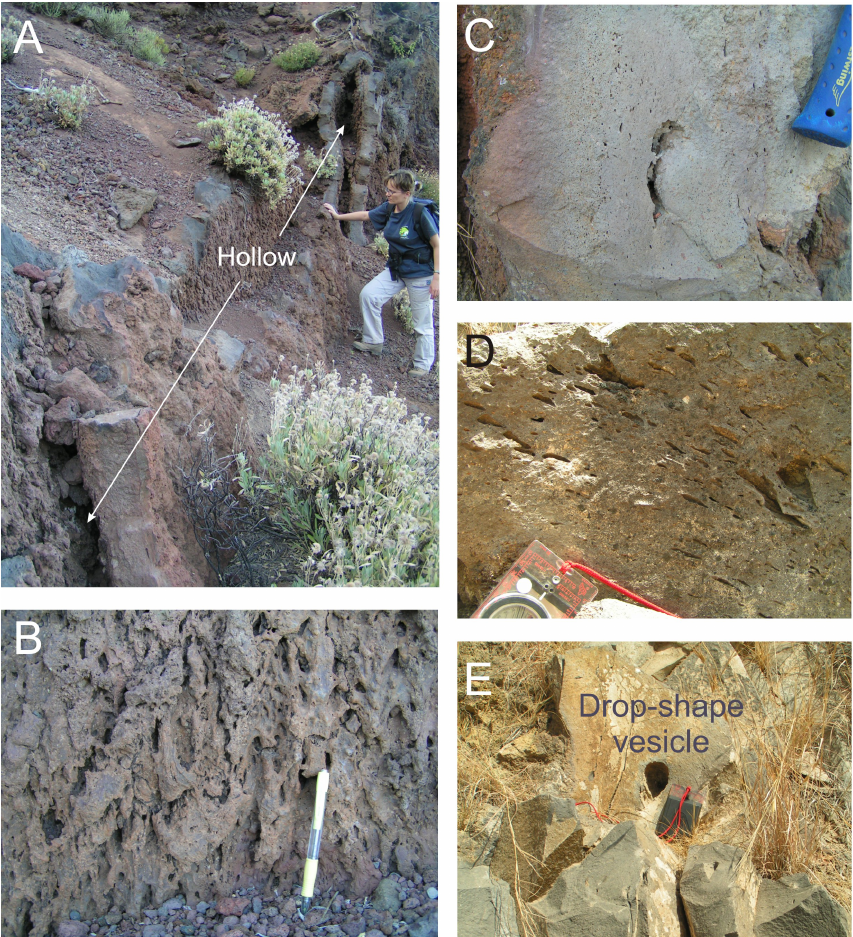
Fig. 7. (A) Central elongated hollow of the Colorada feeder dyke (Tenerife). (B) Details of the magma drops at the central hollow. (C) Vesicles in bands and increasing in size and number from the chilled margins to the dyke centre. (D) Elongated vesicles. (E) A drop or pear-shaped